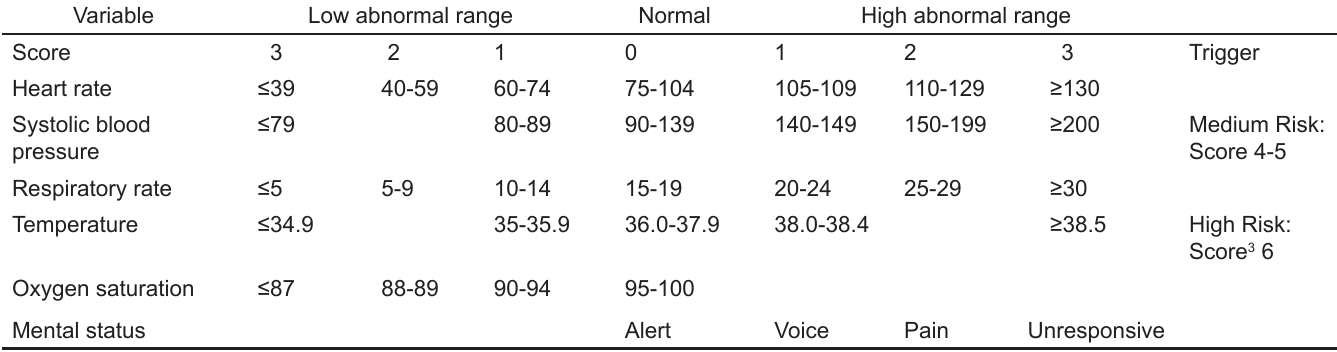
Table 2. Versions of the modified obstetric early warning scoring systems (aggregate score MOEWS)